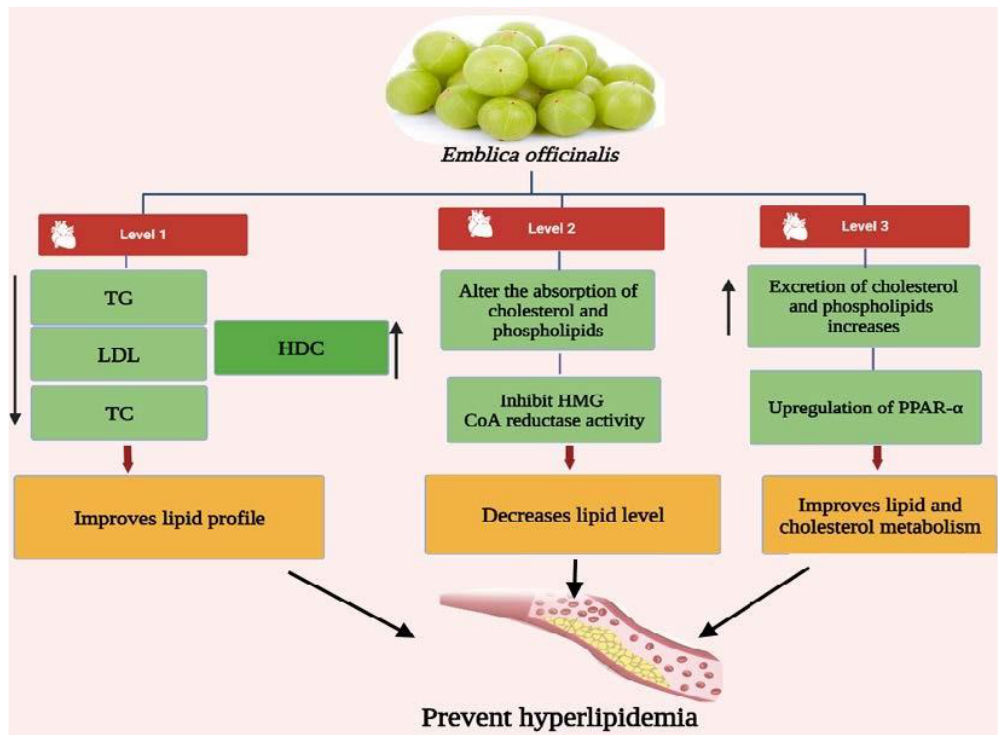
Figure 3. Anti-hyperlipidemia activity of amla bioactive compounds. Figure 3 is adapted from